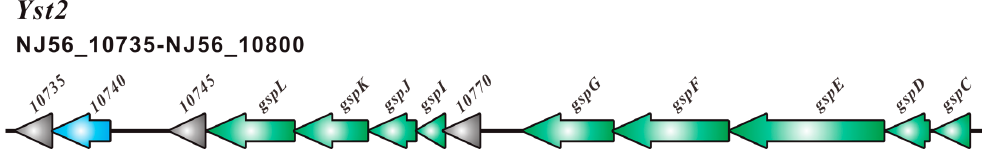
Figure 4. Gene clusters associated with type II secretion system Yst2 in SC09.